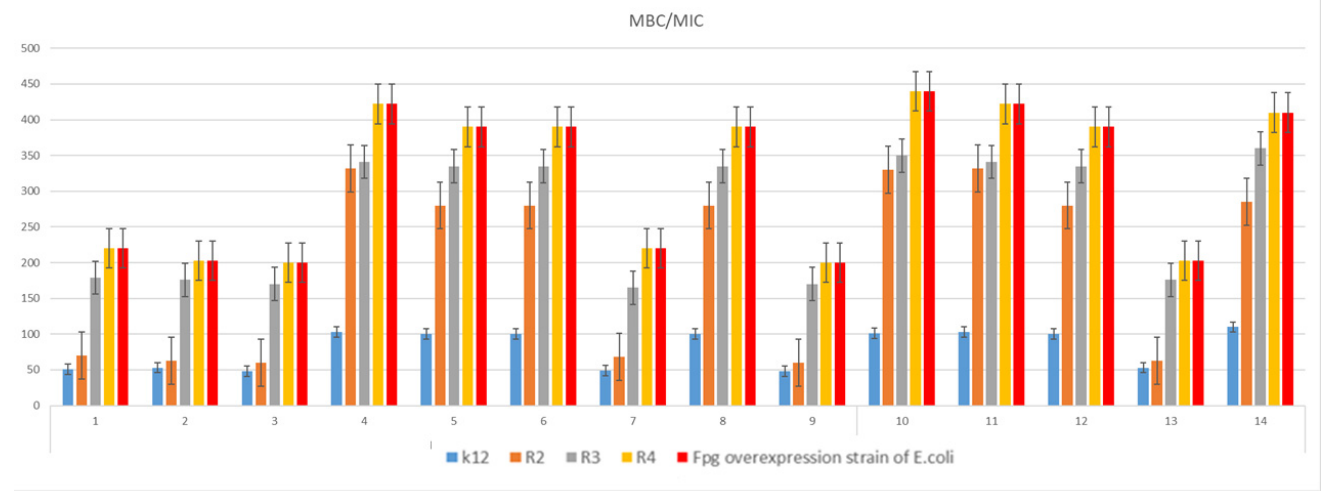
Figure 6. The ratio of MBC/MIC of the coumarin derivatives. The x -axis features compounds 1 – 14 . The y -axis shows the MBC/MIC value in µg/mL. Investigated strains of E. coli K12 as control (blue), R2 strains (orange), R3 strain (grey), and R4 strain (yellow), Fpg overexpression strain (red bars). The order in which the compounds were applied to the plate are shown in Supplementary Materials Figure S1.